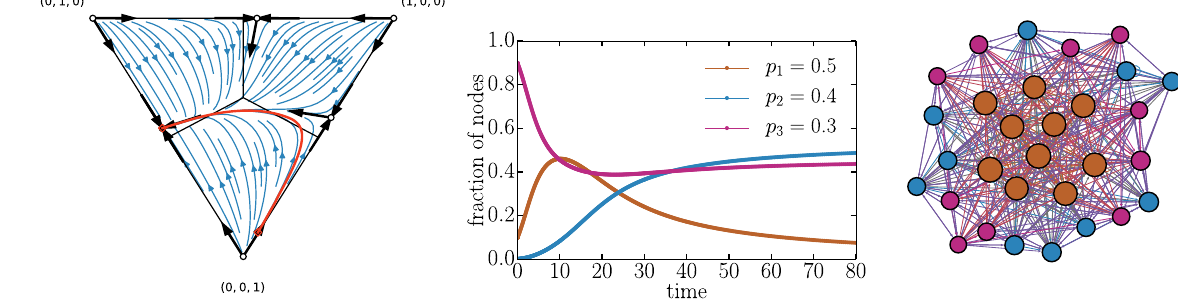
Figure 3. Dynamical trajectories for competitor using strategies p 1 = 0.5, p 2 = 0.4, and p 3 = 0.3. (left) This triangle contains all possible dynamics: we show trajectories through a space where every point is defined by a unique ( x 1 , x 2 , x 3 ) state. Therefore, any point within the triangle correspond to a mixed state where all competitors have non-zero frequencies, whereas the edges correspond to two-competitor dynamics. All stable fixed points are shown as black dots, and semi-stable and unstable fixed points appear as open circles (their stability can also be deduced by the linear flows shown in black arrows around them). We delineate the three regions corresponding to states where one of the three competitors are respectively winning by a relative majority. While competitor 1 uses p 1 = 0.5, which is optimal on a one-on-one basis as shown by the two fixed points close to the (1, 0, 0) apex, it systematically loses when all three strategies are involved. (middle) Example of a time series starting at (0.099, 0.002, 0.899), which corresponds to the one highlighted in the left figure. (right) The network structure when two strategies are aggressive and one is defensive corresponds to a core- periphery structure with the core corresponding to the highest p value. The network display style is the same as used in Fig. 2. The core is denser with nodes having a higher average total degree, but it does not target the periphery whereas nodes on the periphery preferentially targets the core and eventually